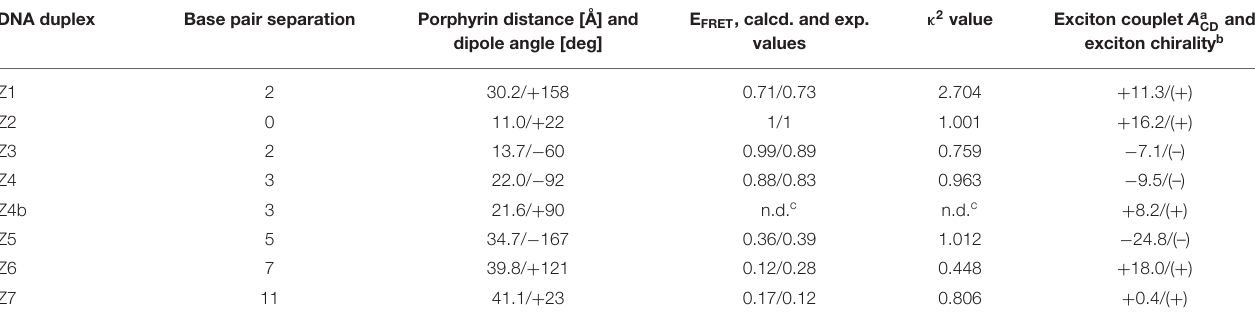
TABLE 1 | Structural parameters, FRET efficiencies and CD data of the donor-acceptor systems. DNA duplex